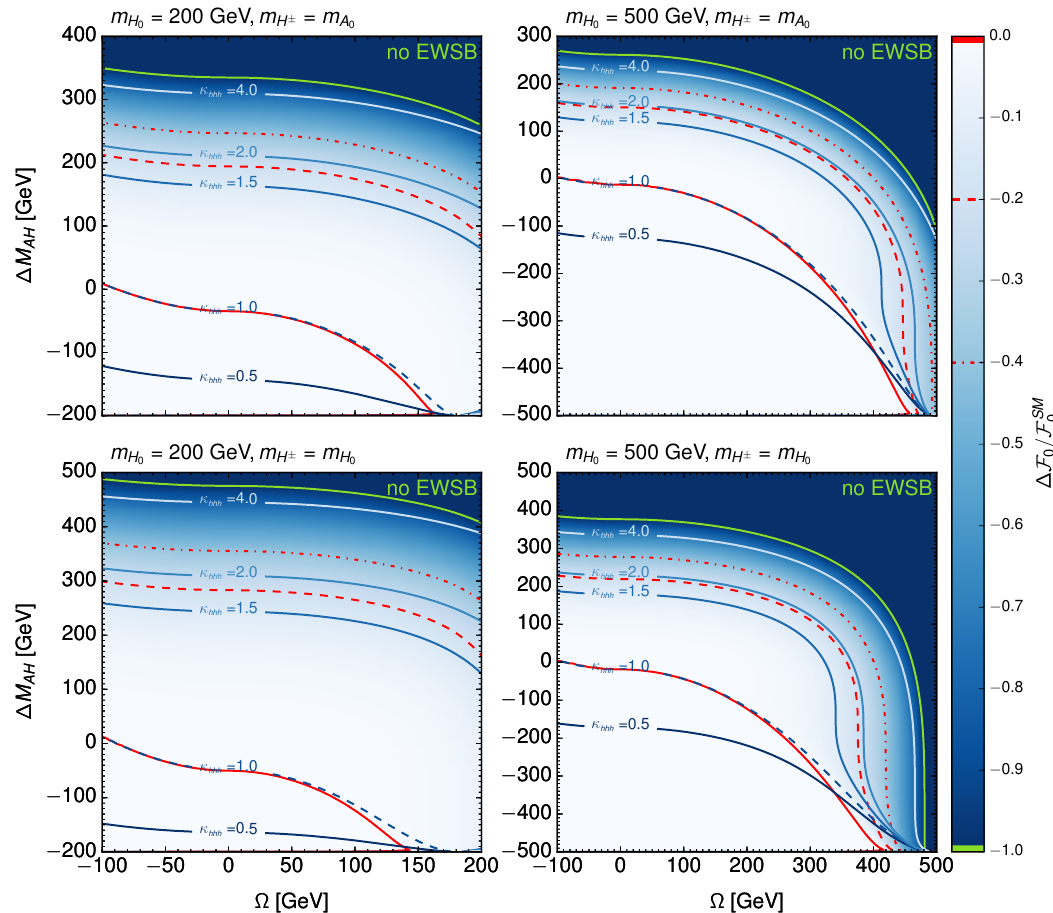
Figure 11 . Contours of the deviation in the 2HDM Higgs self-coupling (cid:20) hhh = (cid:21) hhh =(cid:21) SM ing the vacuum energy di(cid:11)erence. The dashed curve corresponds to (cid:20) hhh = 1, where the prediction is unchanged with respect to the SM. The values of 1.5 and 0.5 correspond to the expected precision envisaged for the HL-LHC. Vacuum energy di(cid:11)erence values of 0 and -1 are also highlighted in which either no EWSB can occur or the vacuum energy di(cid:11)erence is the same as in the SM respectively.